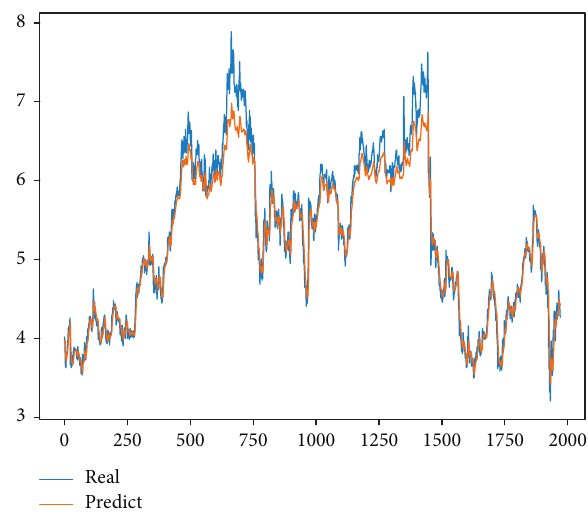
Figure 10: Prediction results of SVR for ASX sequence.